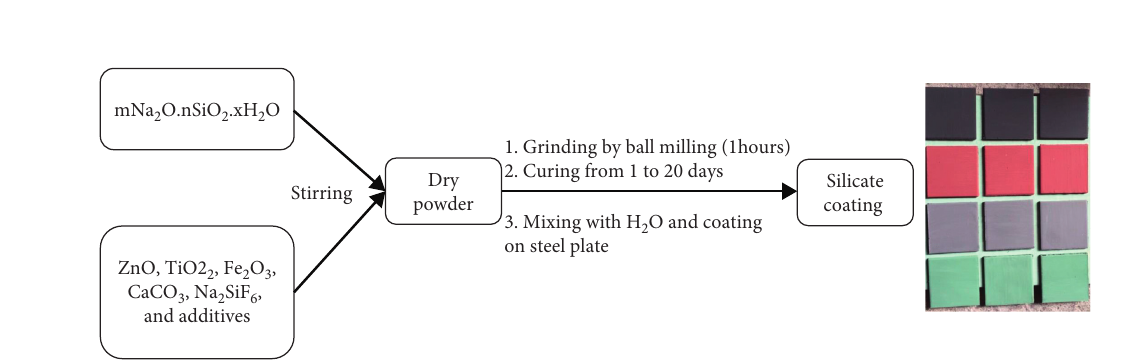
3. Mixing with H 2 O and coating on steel plate